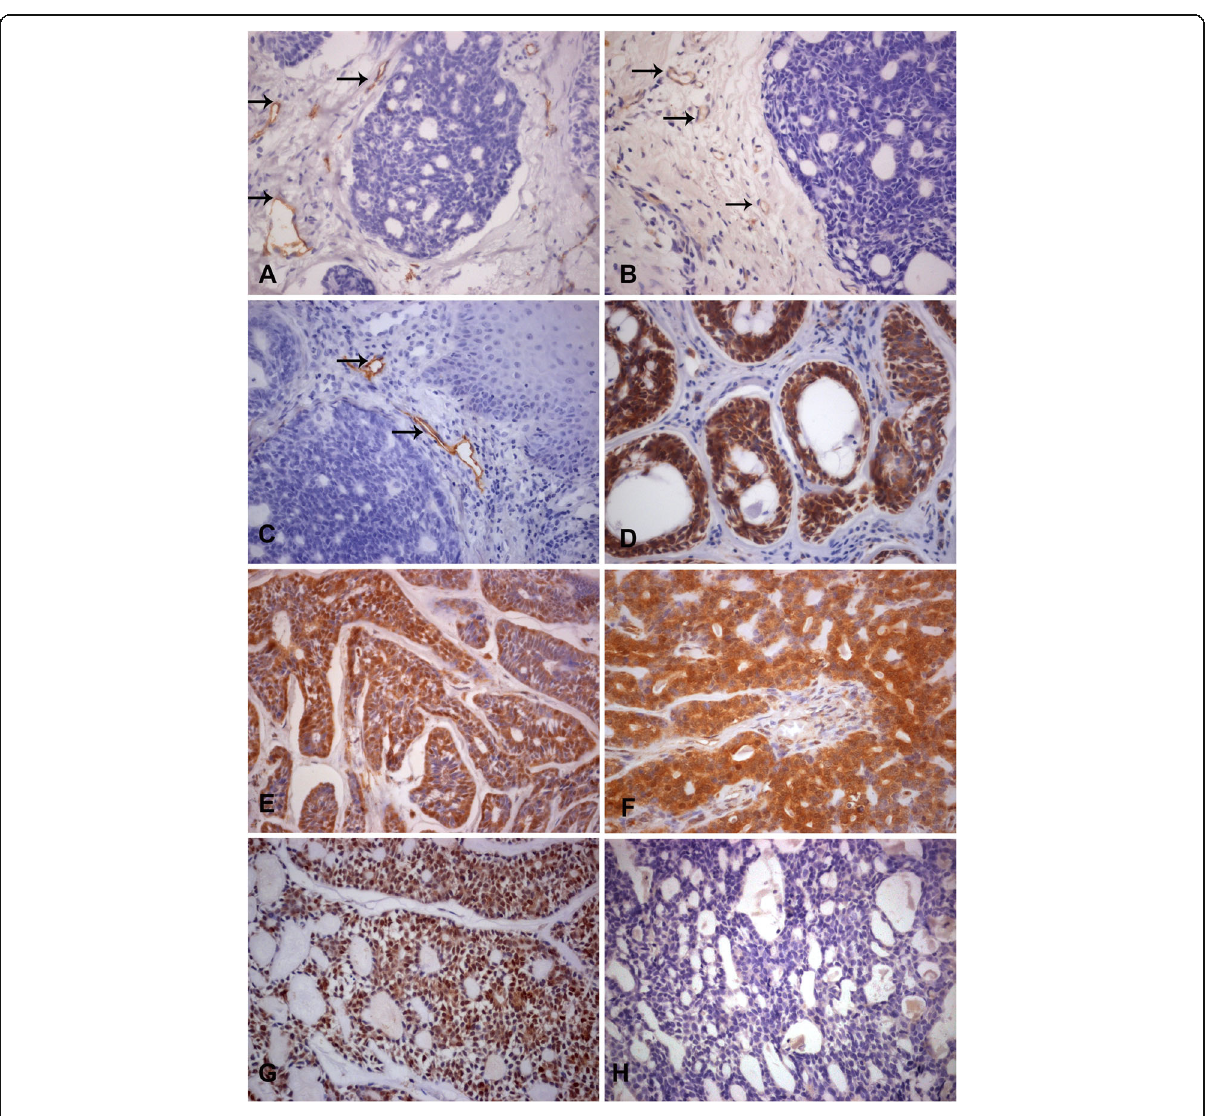
Fig. 1 Immunohistochemistry panel for adenoid cystic carcinoma (ACC) showing expression of CD34 (arrows) in the peritumoral stroma ( a ), unusual CD105 (arrows) positive vessels in peritumoral stroma of rare cases ( b ), infrequent positivity for D2 – 40 (arrows) in peritumoral stroma ( c ), strong Bcl-2 expression in neoplastic cells ( d ), strong Beclin expression in neoplastic cells ( e ), an area with intense positivity for LC3B ( f ), strong p21 positivity in neoplastic cells ( g ), and negative expression for p16 in neoplastic cells ( h